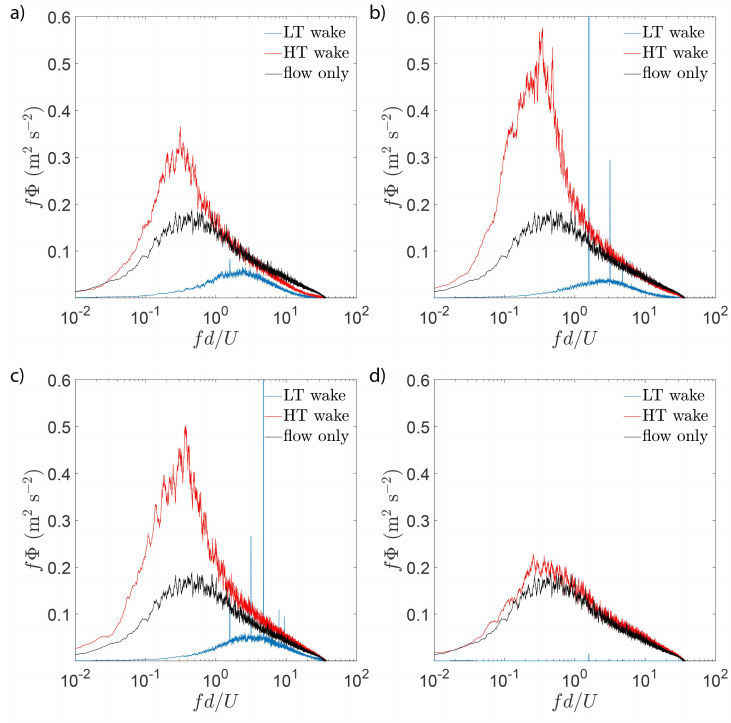
Figure 4. Velocity spectra Φ u at various spanwise locations for x / d = 2. ( a ) y / R = 1/3; ( b ) y / R = 2/3; ( c ) y / R = 1; ( d ) y / R = 4/3.